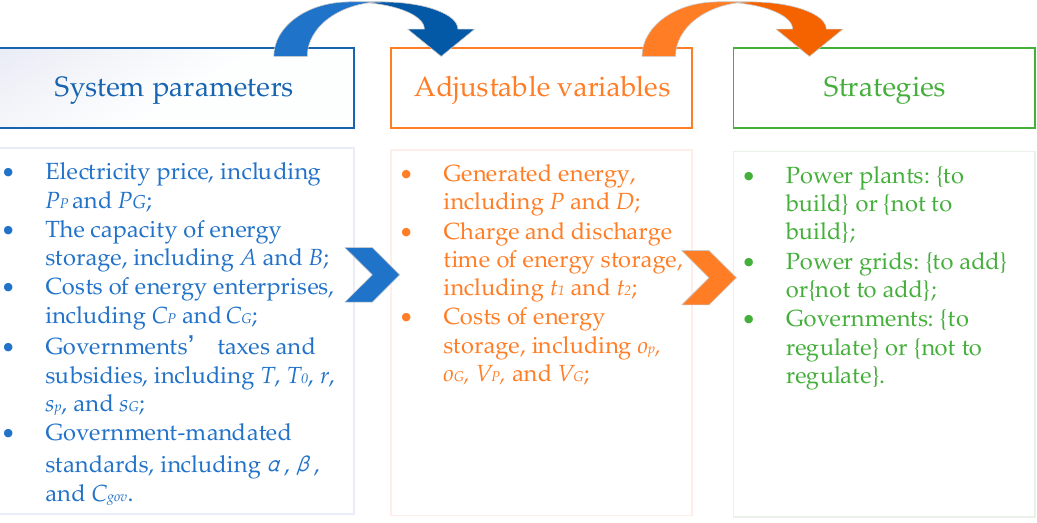
Figure 4. The chain of influence.